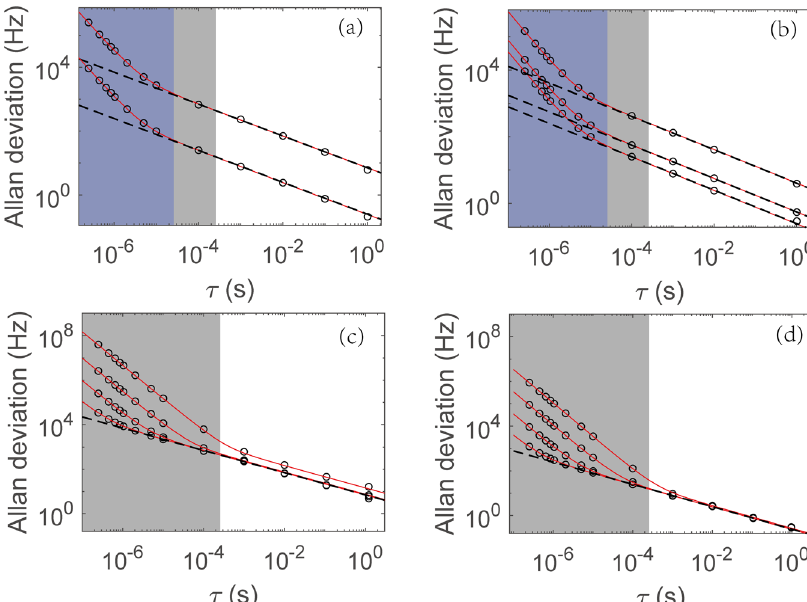
Fig. 3 Frequency Allan deviation and Cramer Rao lower bound for simulated data with added Gaussian detection noise. a Undriven (A = 0, top line) and driven cases (A = 40 σ , bottom line) with η ¼ 0 : 1 and Δω = 0. Black circles are Allan deviation (ADEV) of the frequency estimated by Eq. (25), red solid lines are the corresponding Cramer Rao lower bound (CRLB), Eq. (16), black dashed lines are noiseless CRLB Eq. (19) with η ¼ 0. The blue and gray shades label τ < η Γ and τ < 1 Γ , respectively. b Driven case (A = 40 σ ) with detuning Δ ω ¼ 0, Γ , and 10 Γ (from bottom to top), and η ¼ 0 : 1. c , d Undriven (A = 0) and driven (A = 40 σ ) cases, respectively, with varying added noise level η ¼ 0 : 01 ; 0 : 1 ; 1 ; 10 (from bottom to top) and constant Δω = 0. The one standard deviation uncertainties of the data points obtained from the numerical simulation are smaller than the symbol